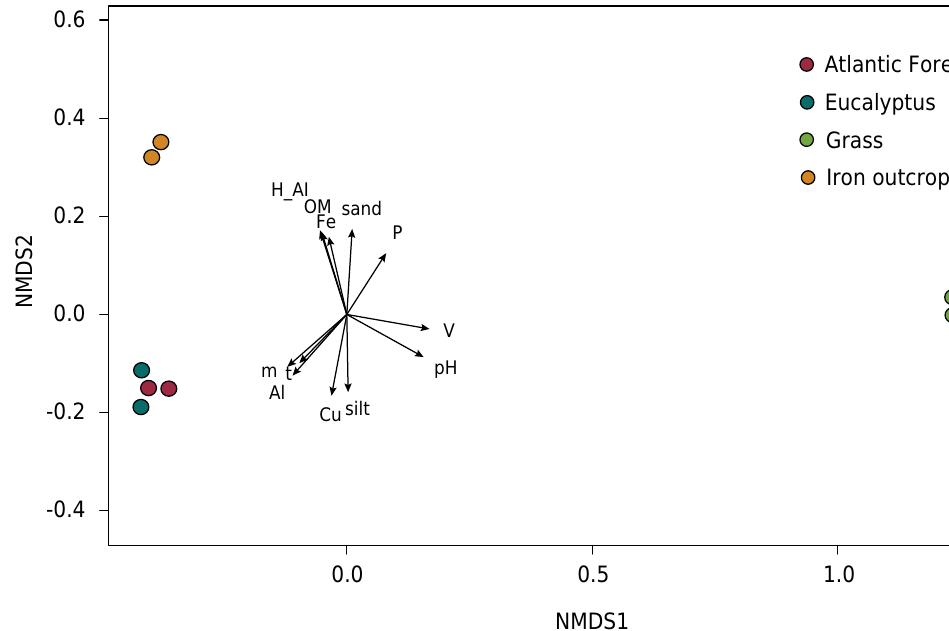
Figure 3. Nonmetric multidimensional scaling (NMDS) plot tracking community similarity and soil variables correlation. Soil variables (permutation test<0.05). P: phosphorus; Al: aluminum;